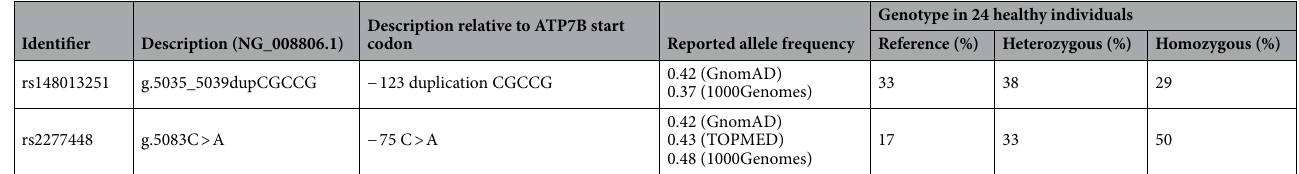
Table 2. Two polymorphisms located in the ATP7B